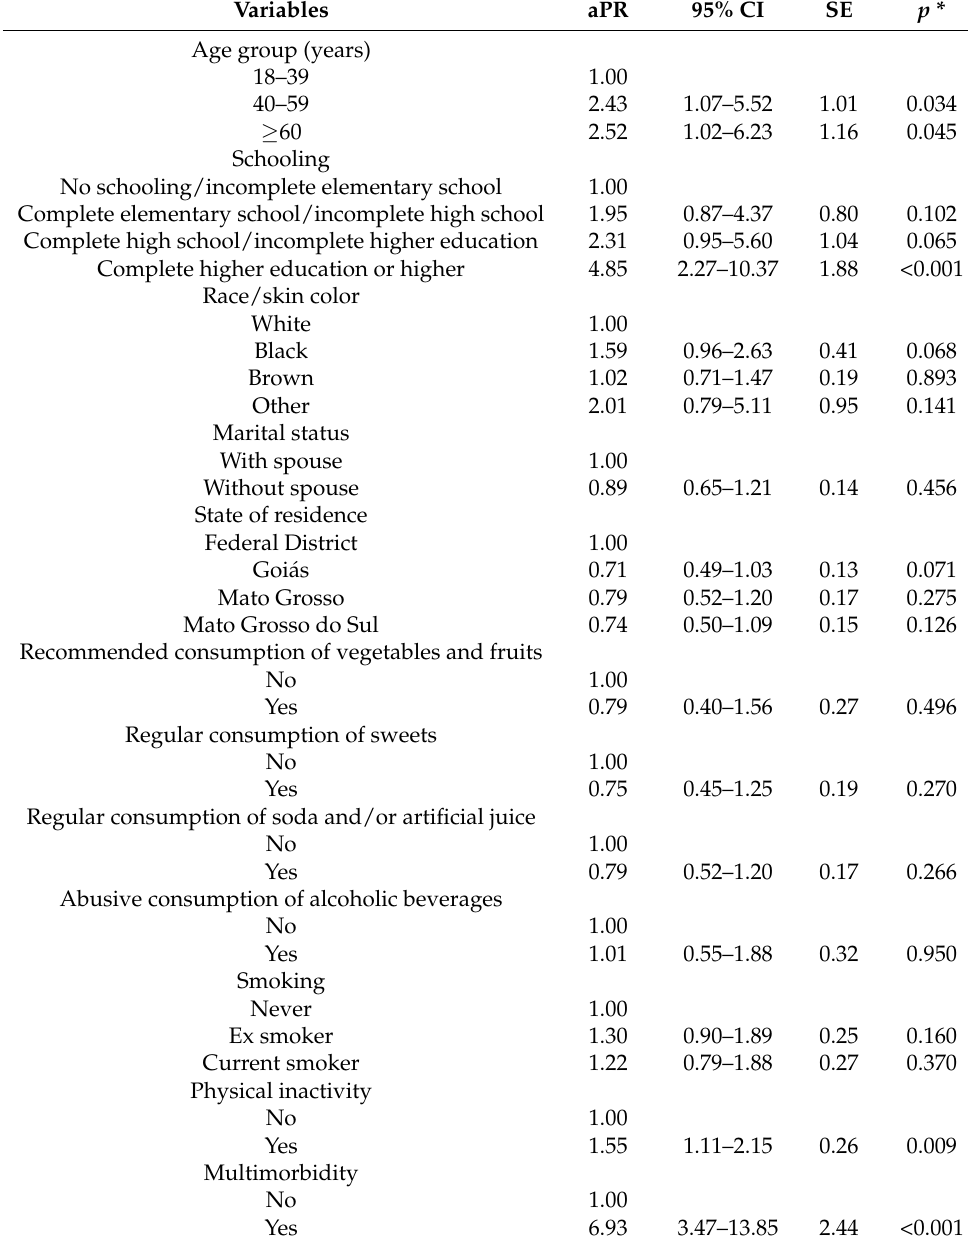
Table 3. Multiple regression analysis of factors associated with negative health self-assessment in women. Midwest Region, Brazil, National Health Survey,